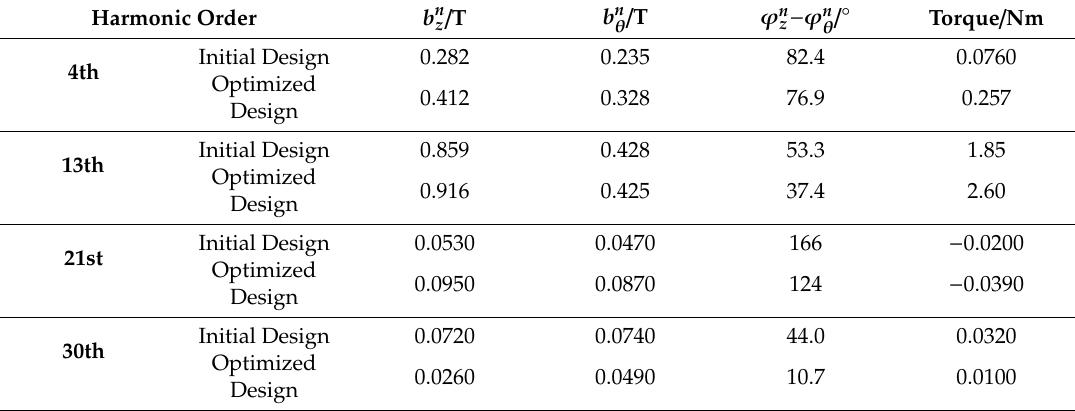
Table 7. Amplitudes, the phase di ff erences and torque due to the air-gap flux density at the radius of R m1 .